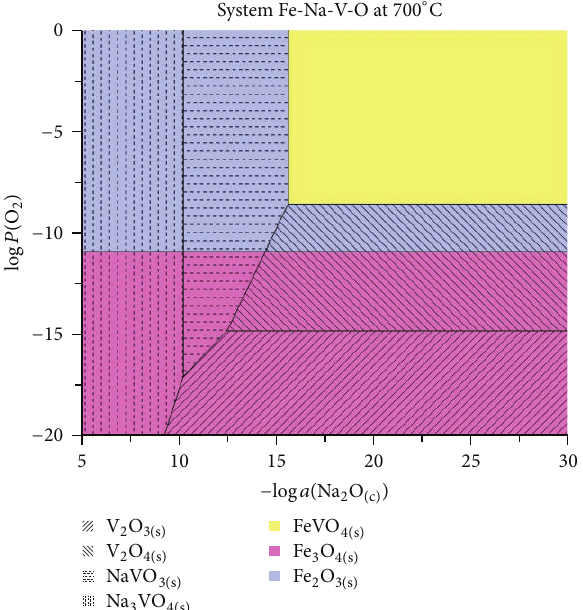
Figure 9: Thermodynamic stability diagrams for Ni-Na-V-O at 700 ∘